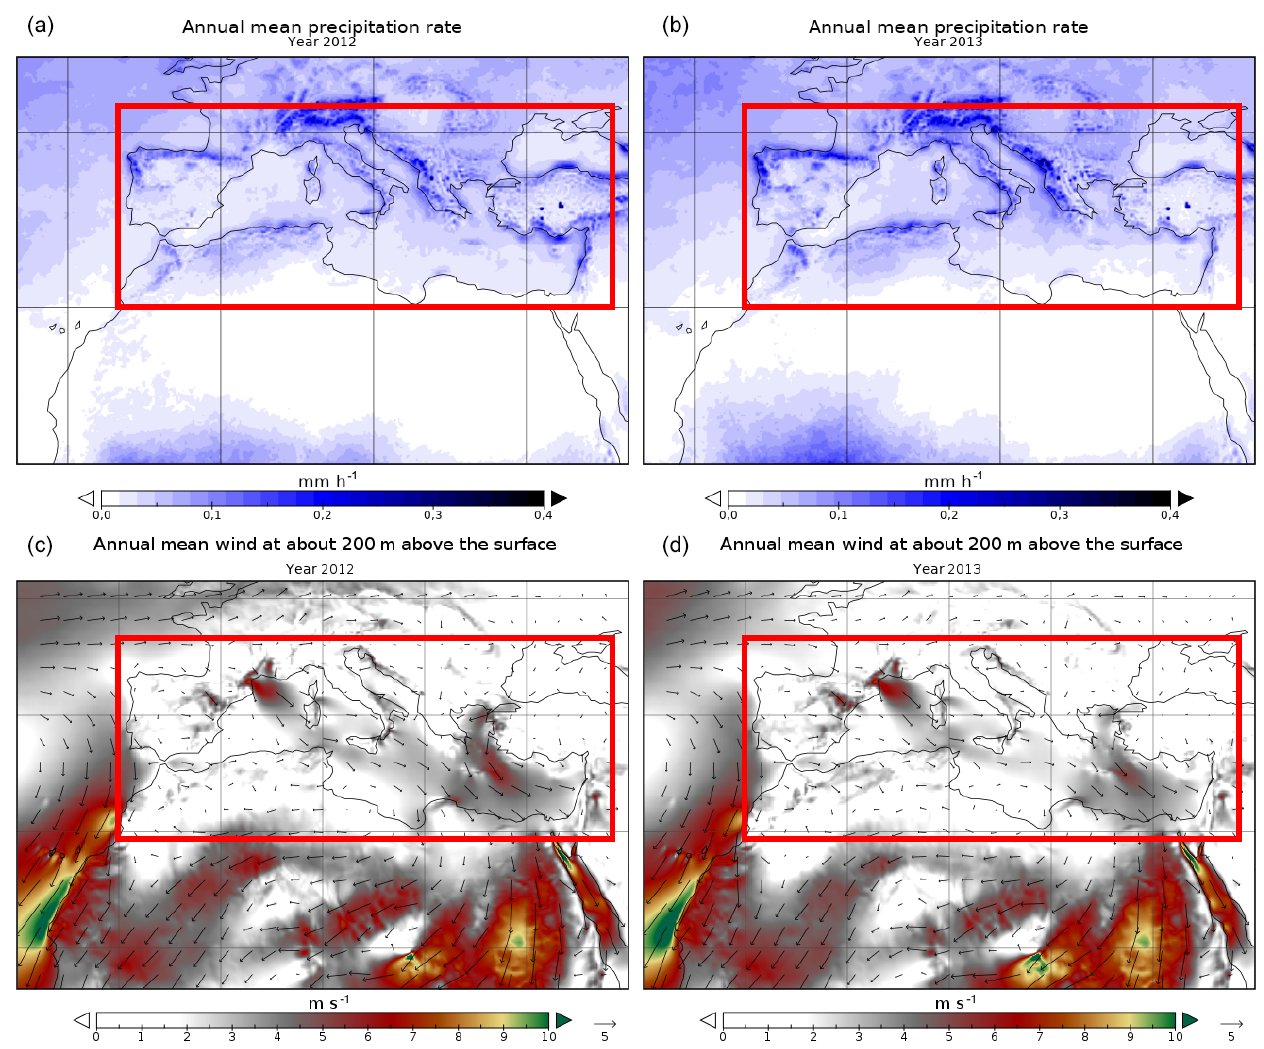
Figure 6. Yearly mean of precipitation rate (top panels) and wind vectors at 200m above the surface (bottom panels) for the year 2012 (a, c) and 2013 (b, d) . The red square on the figures represents the budget